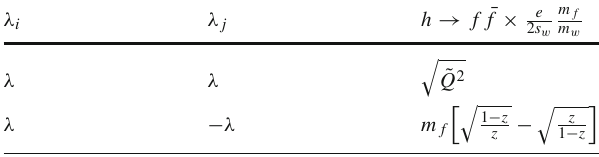
Table 5 Branching amplitudes for Higgs splitting to fermions